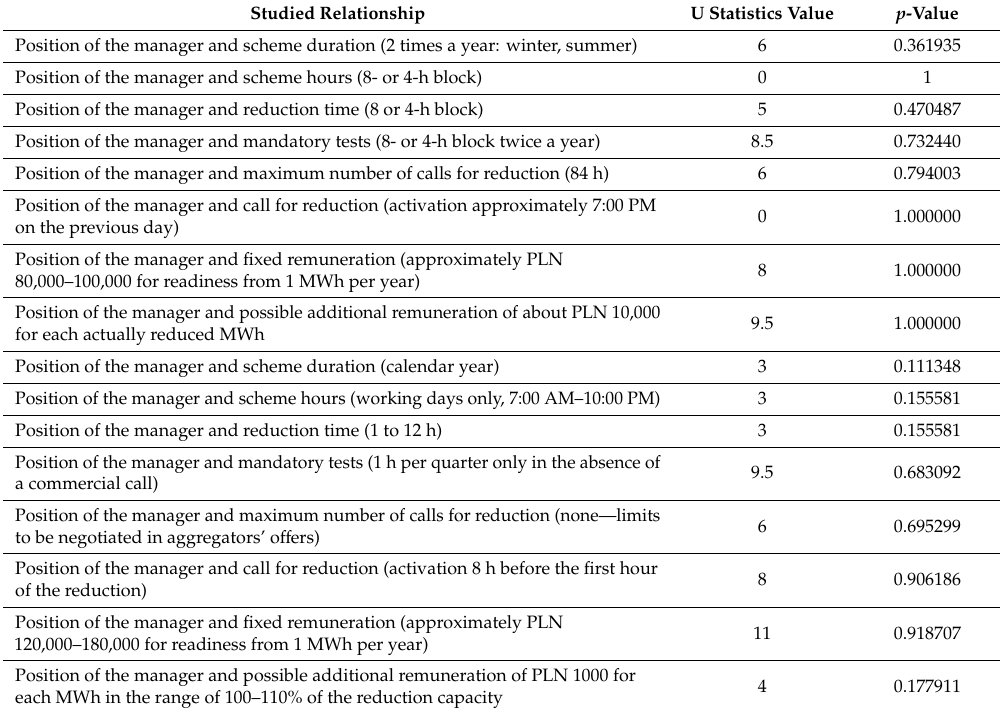
Table 7. Results of the Wilcoxon–Mann–Whitney test for companies divided by the position of the